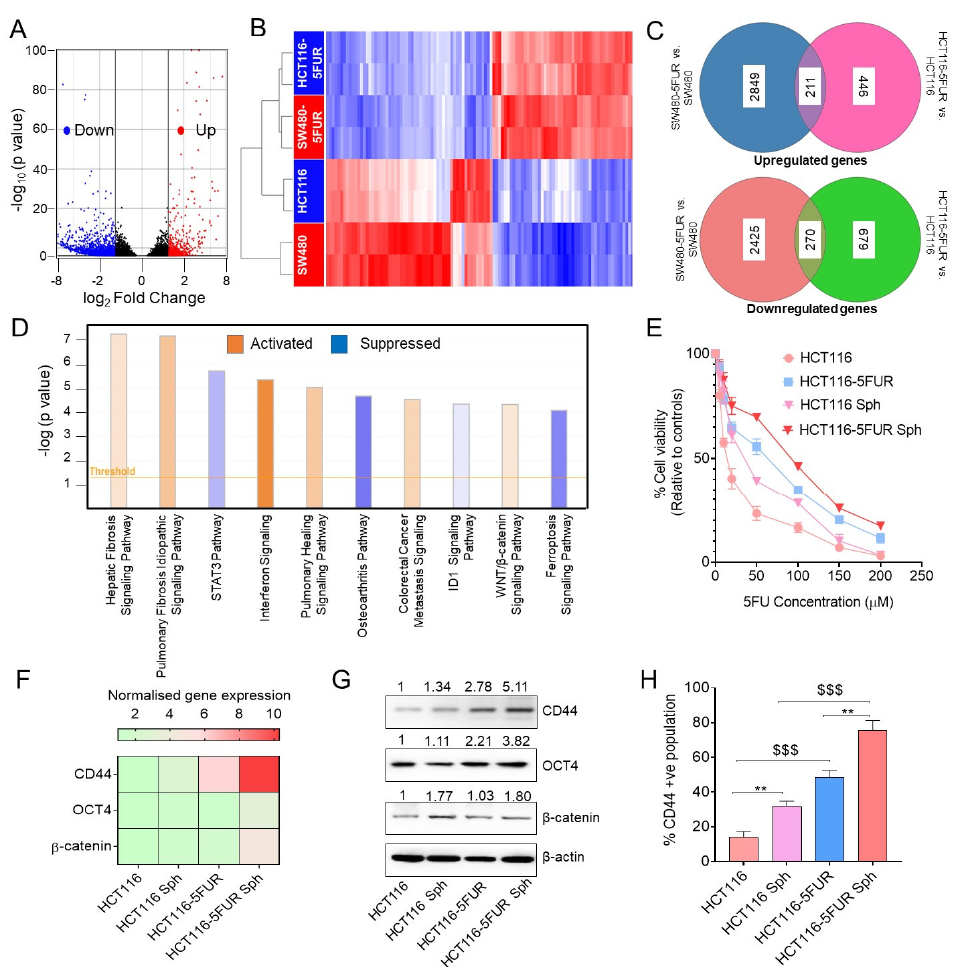
Figure 2. Genome-wide transcriptomic analysis of parental and 5FUR CRC cells and the role of CSCs in promoting chemoresistance in CRC. ( A ) Volcano plot showing differentially expressed genes between parental and 5FUR CRC cells based on log 2 FC > 1 and < − 1 and a p -value of <0.05. (Red-upregulated, blue-downregulated, black-non-significant genes.) ( B ) Heatmap of differentially expressed genes in parental and 5FUR CRC cells. ( C ) Venn diagram analysis represents significant up- and downregulated genes in SW480-5FUR vs. SW480 and HCT116-5FUR vs. HCT116 compared to cells. ( D ) Ingenuity pathway analysis to identify the top 10 significantly activated and suppressed pathways in 5FUR and parental cells based on their − log p -value and Z score. (Orange-positive Z score, blue-negative Z score.) ( E ) Comparison of percentage cell viability of parental and 5FUR CRC cells and their corresponding spheroids after treatment with different concentrations of 5FU (5–200 µ M). ( F ) Gene and ( G ) protein expression analysis of CSC markers (CD44, OCT4) and β - catenin in parental and HCT116-5FUR cells and their respective spheroid counterparts. Original blots see Figure S2. ( H ) Flow cytometric analysis of the CD44-positive population in parental and HCT116-5FUR cells and their corresponding 3D spheroids. Statistical significance was determined by a Student’s t -test. (Comparison between HCT116 vs. HCT116 spheroids and HCT116-5FUR vs. HCT116-5FUR spheroids-** p < 0.01; comparison between HCT116 vs. HCT116-5FUR and HCT116 spheroids and HCT116-5FUR spheroids- $$$ p < 0.001; P = parental CRC cells, R = 5FU-resistant CRC